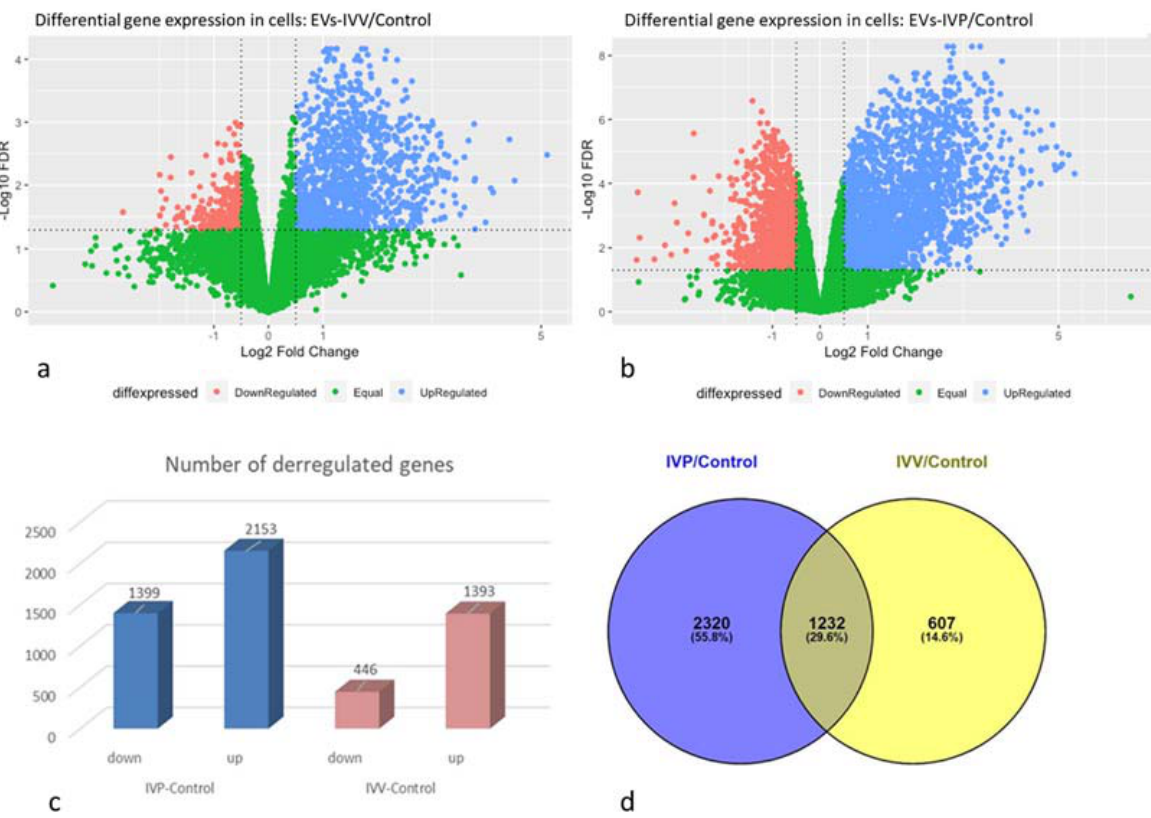
Figure 4. Analysis of deregulated genes in bovine epithelial endometrial cells due to the e ff ect of extracellular vesicles released during blastulation by bovine embryos produced in vivo (IVV) or in vitro (IVP). ( a , b ): Volcano plot showing the comparison between EVs from IVV embryos and PBS (negative control) and between EVs from IVP embryos and PBS (negative control), respectively. ( c ): Number of deregulated genes (up or down), comparing EVs from in vitro produced embryos with PBS (IVP-control), and EVs from in vivo produced embryos with PBS (IVV-control). ( d ). Venn dia- gram of di ff erentially expressed genes from the analyses. Venn diagram was constructed using Venny 2.1 h tt ps://bioinfogp.cnb.csic.es/tools/venny/; accessed on 6 December 2022.